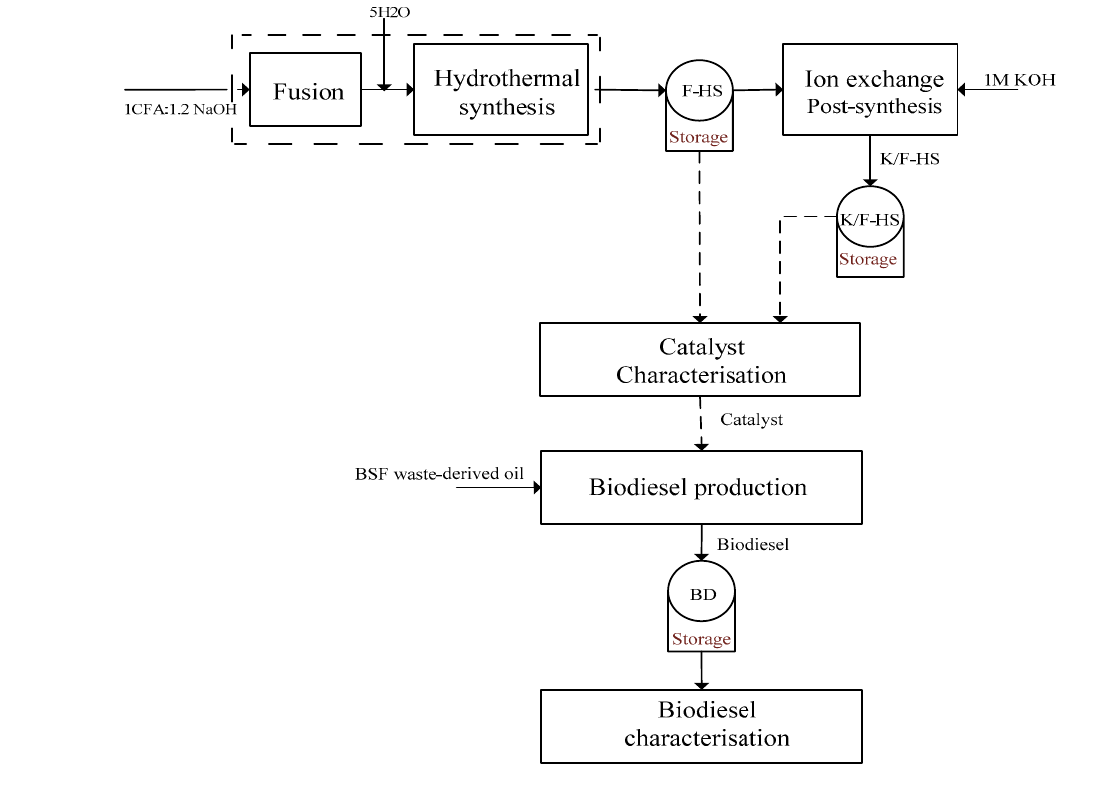
Figure 7. Schematic diagram illustrating the experimental processes (detailed process for IE in Figure S1, for BD in Figure S2).